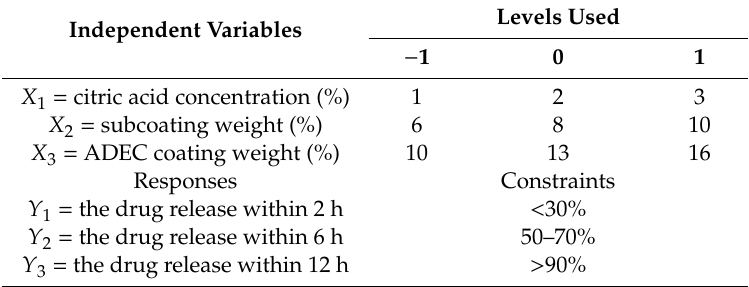
Table 1. The factors and responses of the Box-Behnken design.